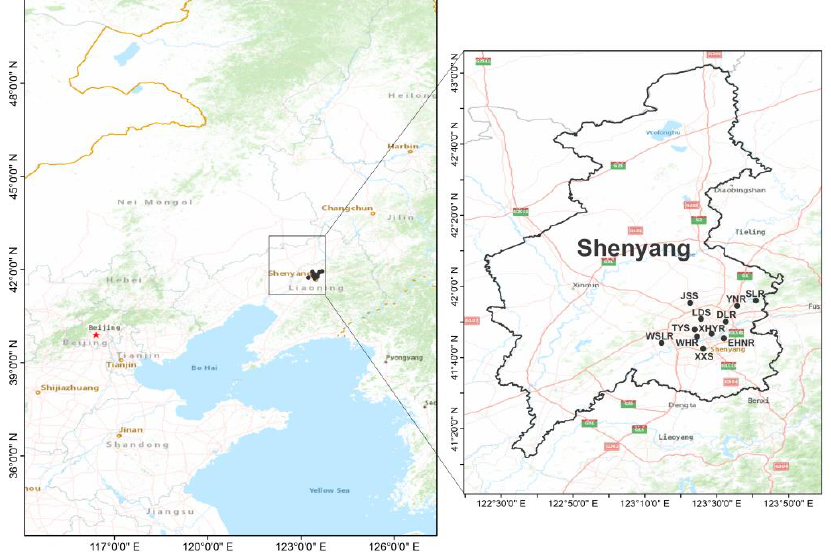
Figure 1. Air quality monitoring stations of Shenyang.